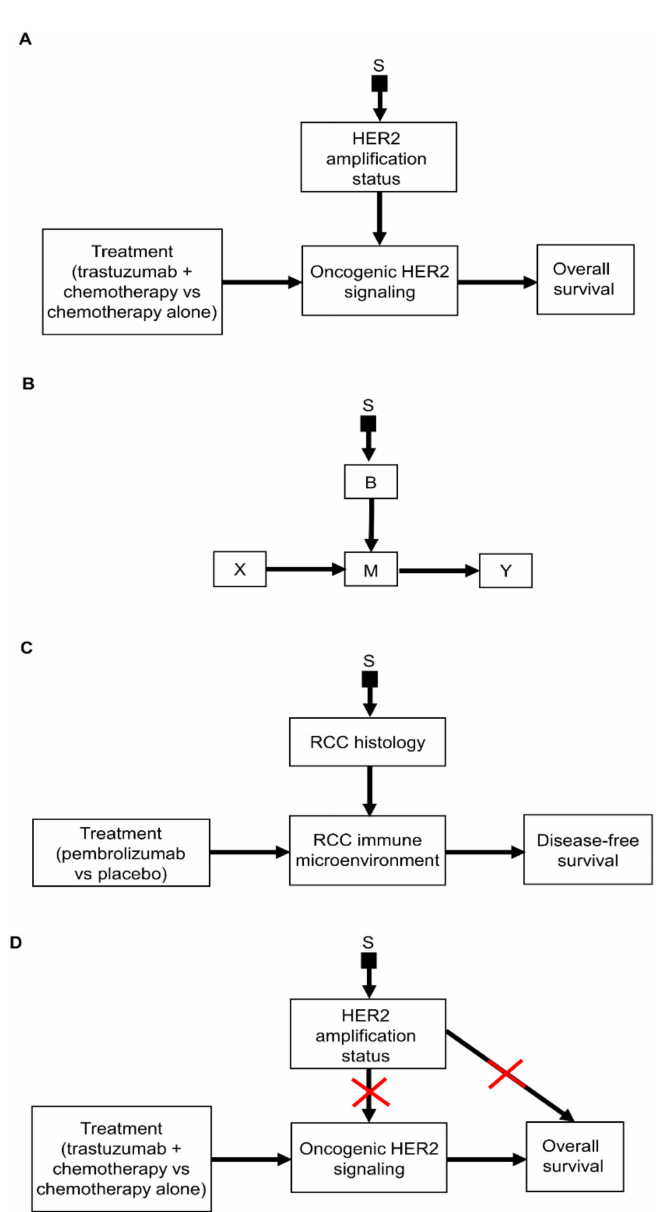
Figure 7. Selection diagrams representing biological treatment effect modification: ( A ) Clinical sce- nario of a randomized clinical trial comparing the survival outcomes of trastuzumab, an inhibitor of human epidermal growth factor receptor 2 (HER2) signaling, in combination with chemotherapy versus chemotherapy alone in patients with metastatic breast cancer. HER2 amplification status influ- ences oncogenic HER2 signaling, mediating the treatment effect. The selection node S denotes that HER2 amplification status can vary across populations; ( B ) Biological treatment effect modification framework where the effect of a randomized treatment X on the outcome Y is mediated by M. The mediator M is influenced by the biomarker B, which can vary across populations, as denoted by the selection node S; ( C ) Clinical scenario whereby the effect of the randomized treatment choice between adjuvant pembrolizumab or placebo on DFS is mediated by the RCC immune microenvironment, which is influenced by RCC histology. The latter can vary across populations, as denoted by the selection node S; ( D ) Clinical scenario where HER2 amplification status is both a predictive biomarker (as shown by the arrow toward oncogenic HER2 signaling) and a prognostic biomarker (as shown by the direct arrow toward overall survival). Covariate weighting for HER2 amplification status will block both pathways (as indicated by the red crossmarks) from the selection node S to the overall survival